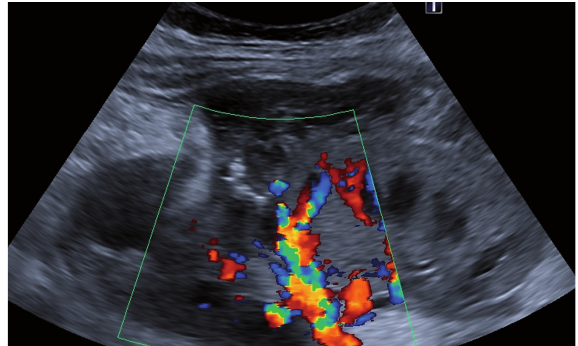
Figure 3 - superselective catheterization of the interlobular artery.